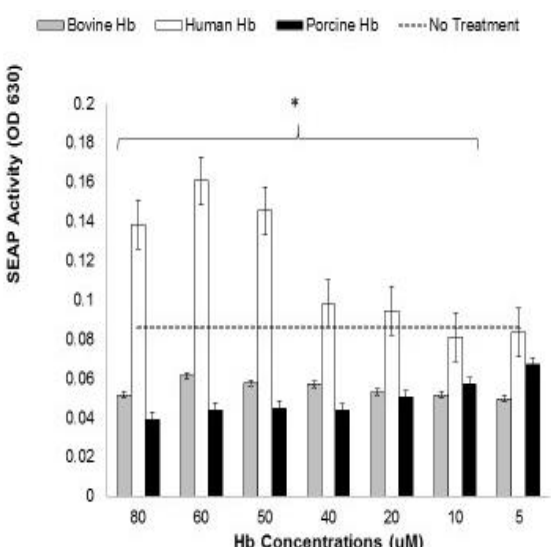
Figure 4. Comparison of TLR4 stimulation and NF- κB demonstrated by Hbs derived from different species (xenogeneic Hb). Human, bovine, and porcine Hb (Sigma) were diluted to equal molar concentrations before addition to HEK hTLR4 cells. After 24 h incubation with the ligands, 20 µL supernatant aliquots were added to QUANTI-Blue TM substrate solutions and incubated for 20 min. The OD 630 nm was measured. Data shown here are the means of quadruplicate treatments (+/ − SEM) and the data are drawn as multiple bar graphs to compare the independent SEAP values respective to the background SEAP production (dashed line) with HEKTLR4. ANOVA comparisons between the human Hb and each of the other Hbs are designated by a horizontal bracket, and the asterisk (*) denotes significance over that entire range of human Hb dilutions where p < 0.05.